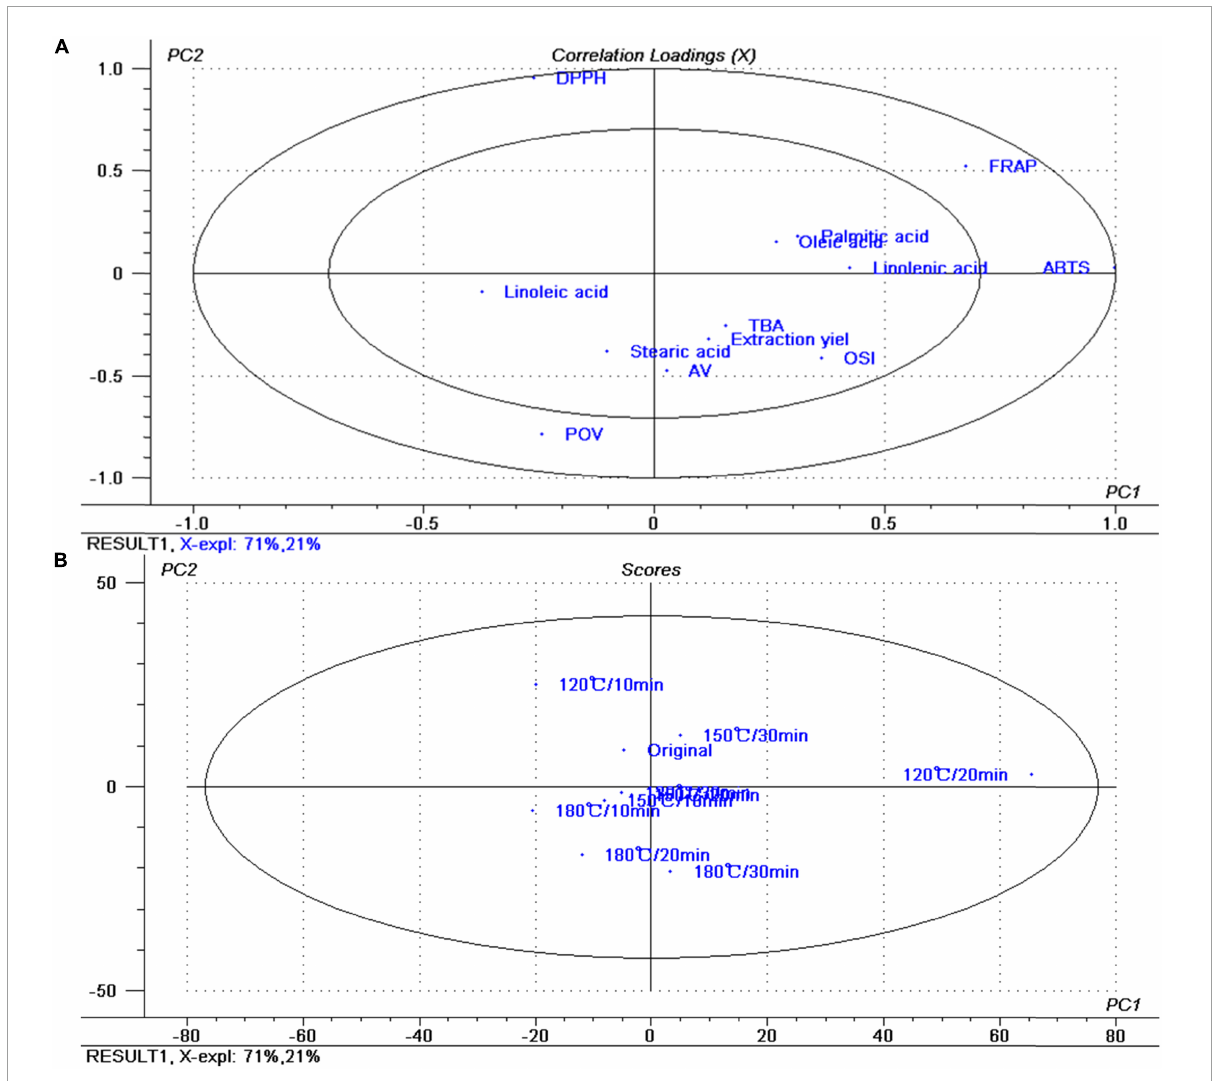
FIGURE2 Principal component analysis of the data. (A) Loadings plot. (B) Scores